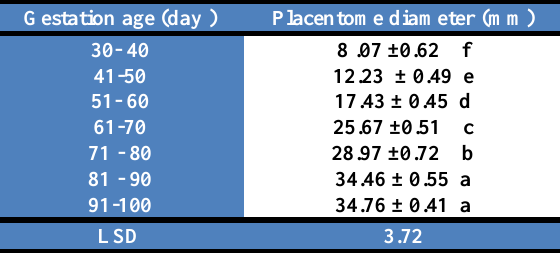
Table, 1: Ultrasonography measurements of placentome at different period of pregnancy in shami